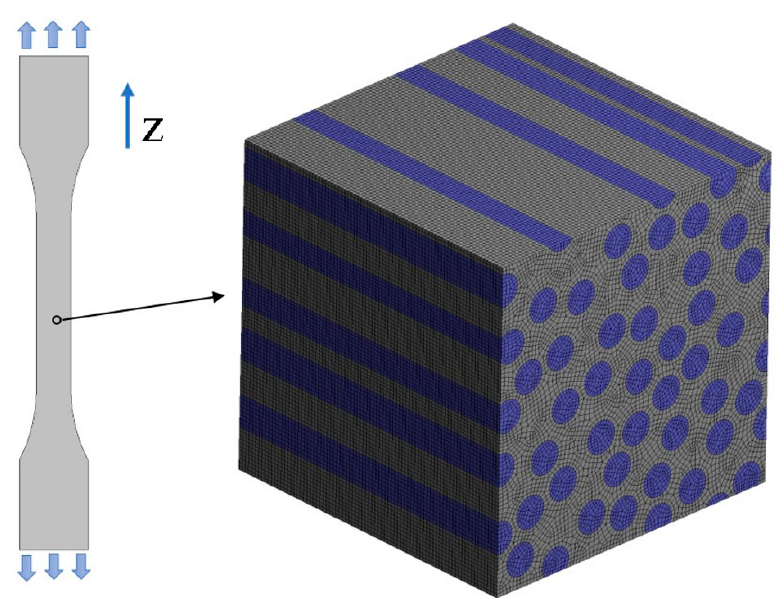
Figure 9. Virtual tensile test along the Z axis, representative volume element (RVE) representing the microstructure of the composite.